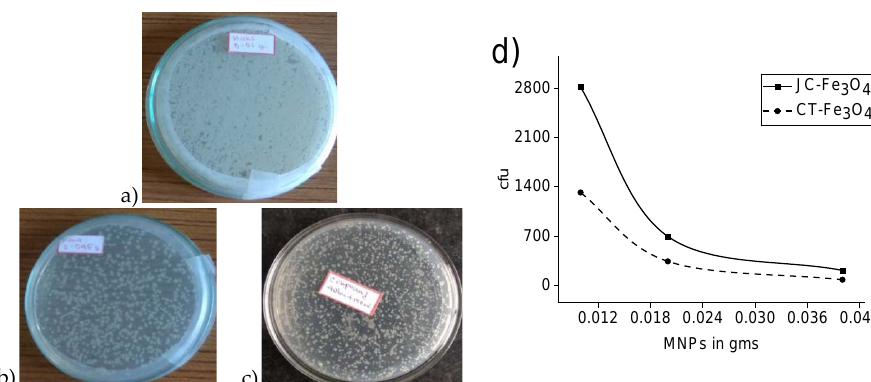
Figure 9. Images of bacterial culture: ( a ) untreated pond water; ( b ) with CT-Fe 3 O 4 ; ( c ) with JC-Fe 3 O 4 ; ( d ) bacterial concentration with respect to amount of MNPs.